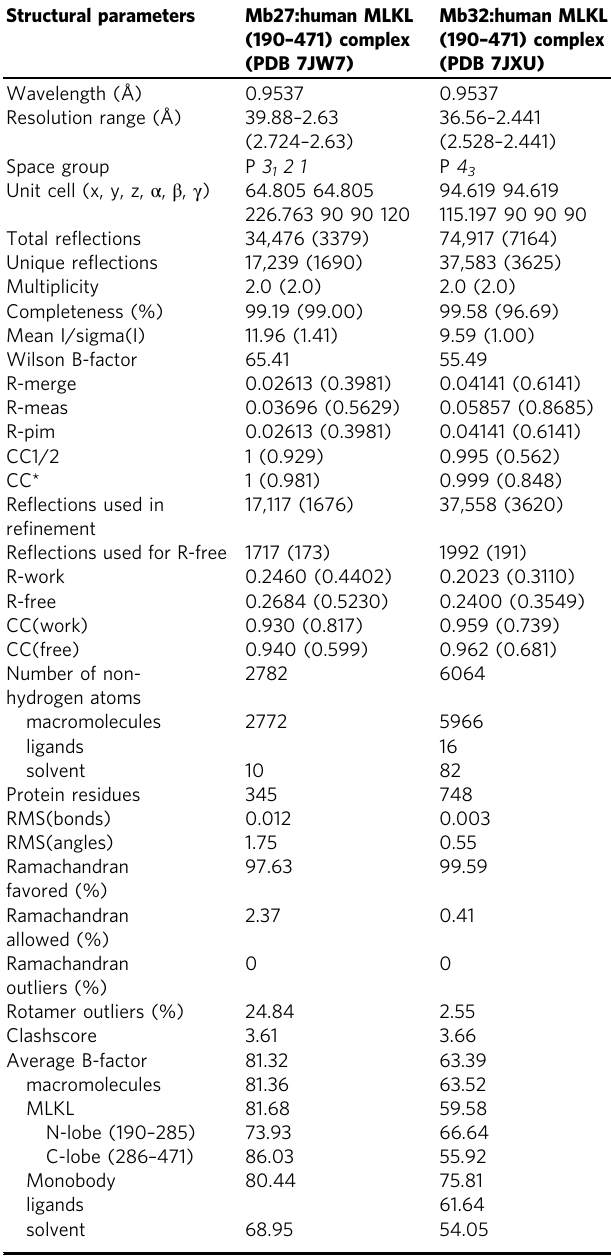
Table 1 X-ray crystallography data collection and re fi nement